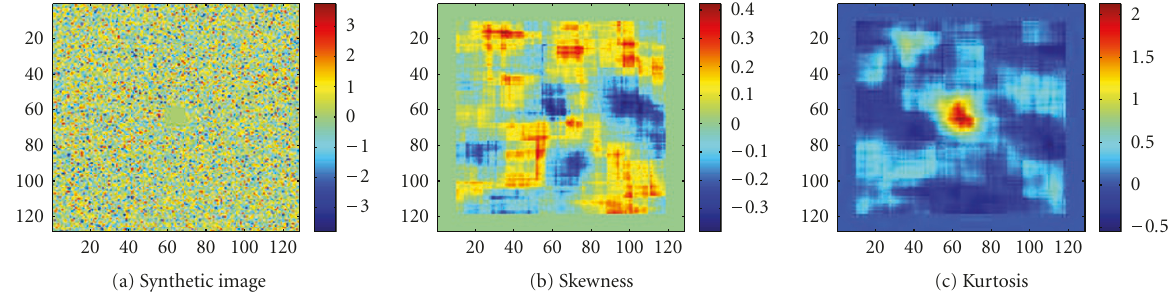
Figure 6: HOS evaluated on 21 × 21 windows (SNR = − 60 dB).